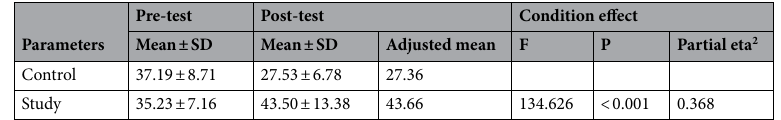
Table 5. Descriptive statistics and ANCOVA results of Post-Test (after 20 weeks of intervention) biochemical parameters between the control (pregnant women with risks of GH receiving routine standard antenatal care alone) and study group (pregnant women with risks of GH receiving routine standard antenatal care + Yoga) subjects. Pre-Test: recordings before intervention, at 16th week; Post-Test: recordings after 20 weeks of intervention, at 36th week. Comparison of data between the Control (Post) and Study (Post) was done by analysis of covariance (ANCOVA). The p value < 0.05 was statistically considered significant. FBG fasting blood glucose, HOMA-IR homeostatic model assessment-insulin resistance, TC total cholesterol, TG triglycerides, HDL-C high density lipoprotein cholesterol, LDL-C low density lipoprotein cholesterol, VLDL-C very low- density lipoprotein cholesterol, AIP atherogenic index of plasma, hsCRP high-sensitive C-reactive protein, IL-6 interleukin-6, OS oxidative stress, MDA malondialdehyde, ED endothelial dysfunction; NO, nitric oxide.